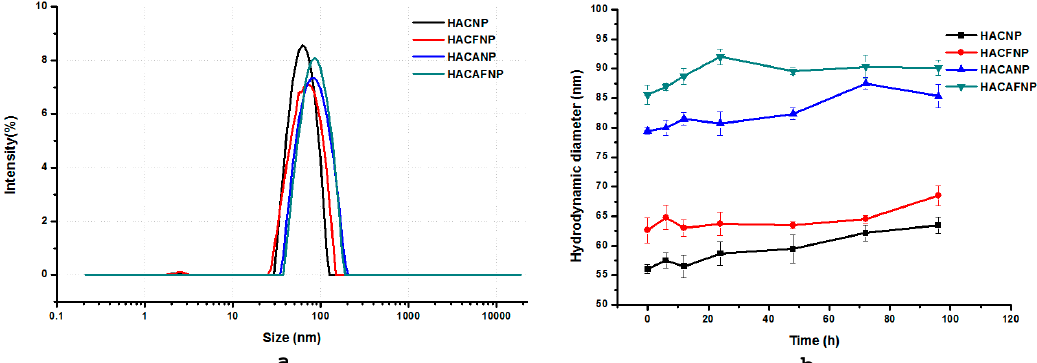
Figure 3. Hydrodynamic diameter ( a ) and nanoparticle stability ( b ) of chitosan nanoparticles (pH = 7.4). Data are presented as mean value ± SD. Table 2. The polydispersity index (PDI) and zeta potential (mV) of chitosan. nanoparticles. Samples